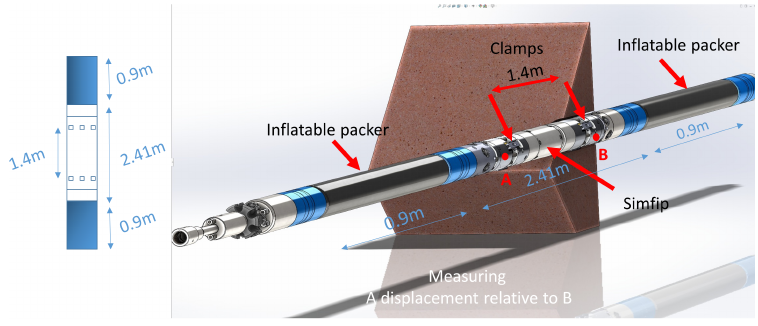
Figure 11. The SIMFIP packer and floating body